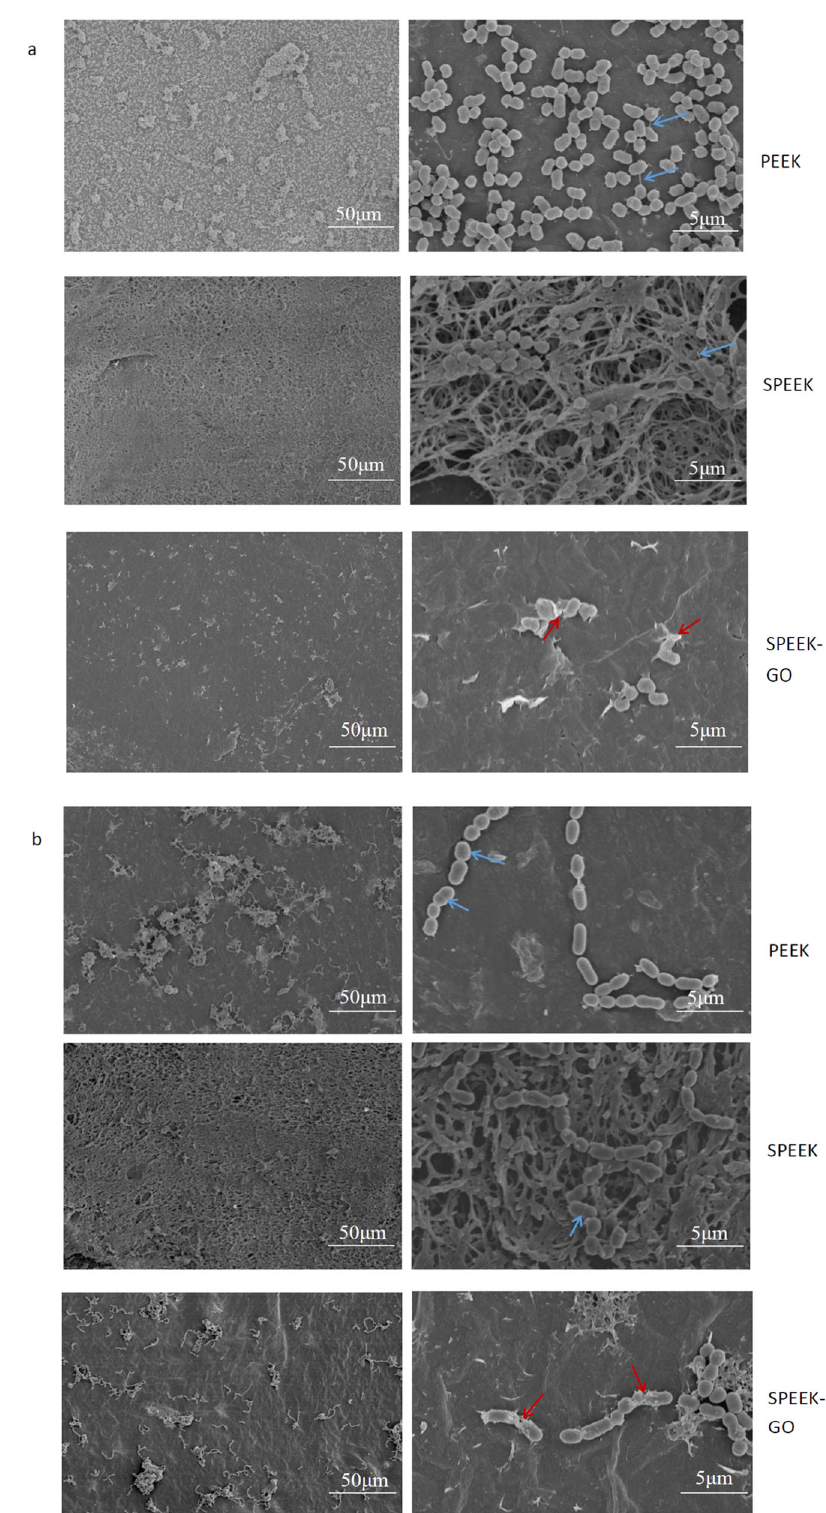
Fig. 9 SEM image of bacterial bio fi lm on the surface of specimens. a SEM image of P. gingivalis on each sample; ( b ) SEM image of S. mutans on each sample. The blue arrows show that the bacterial cilium structure was clearly visible. The red arrows show that the bacteria appeared to shrink, and deformation and cell membrane damage were